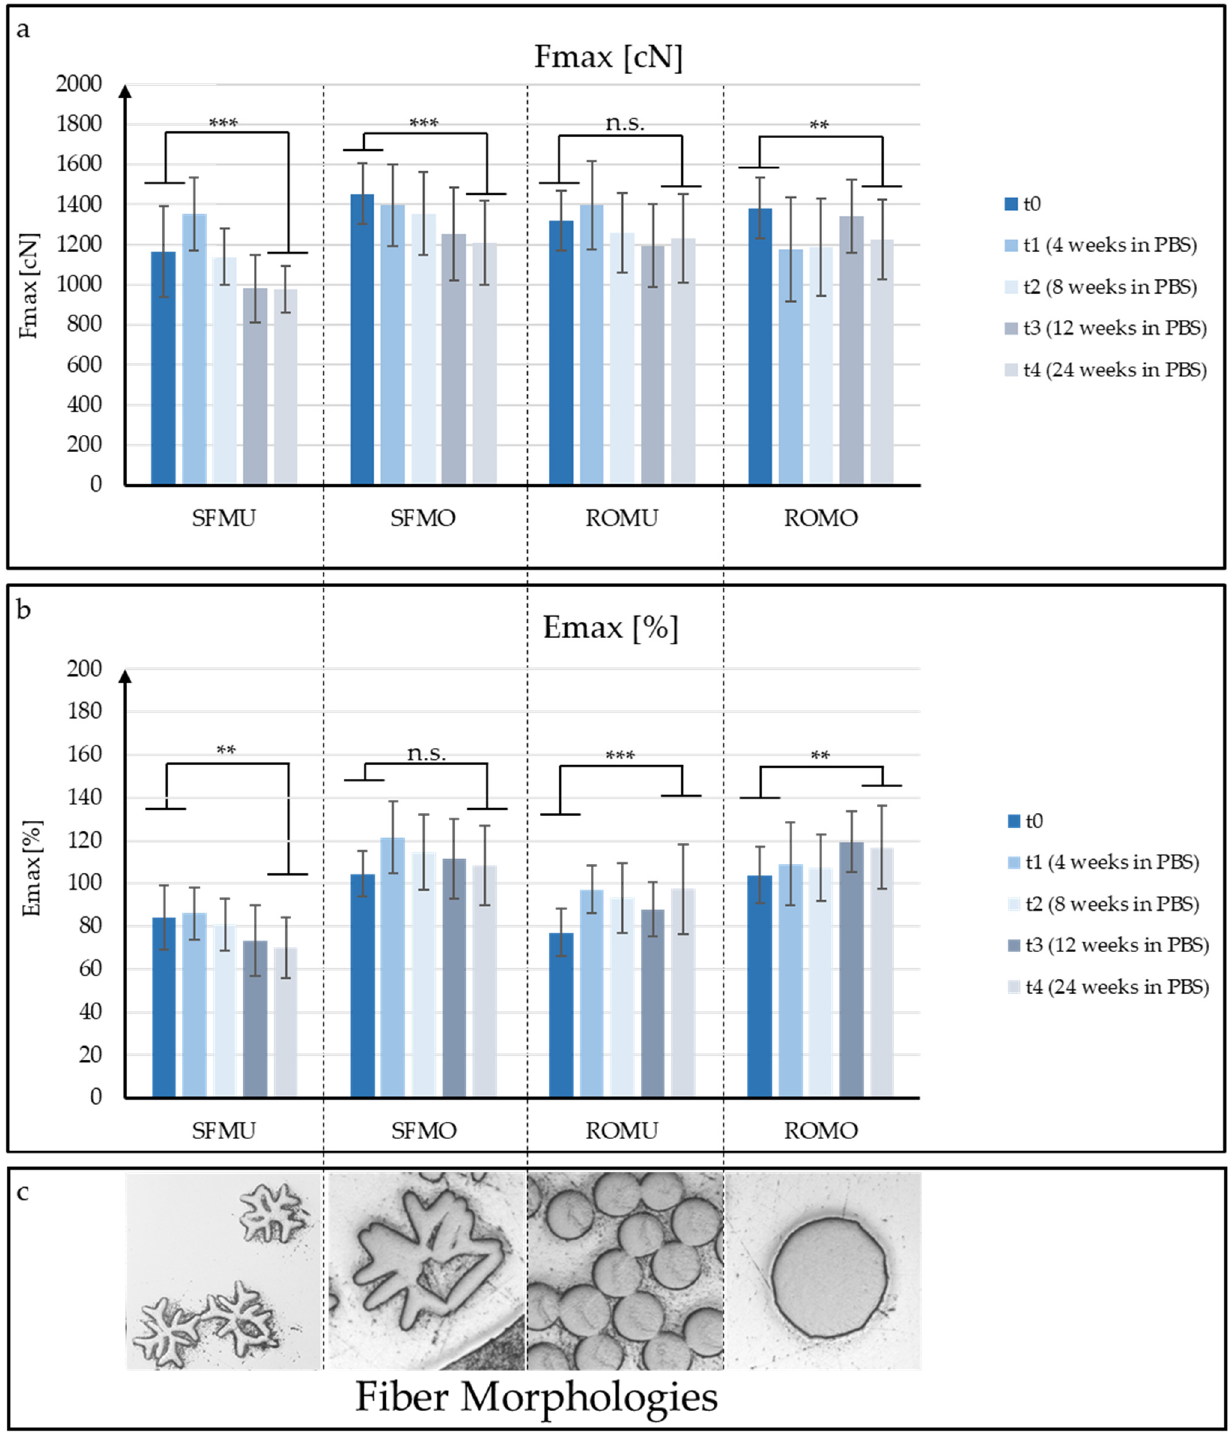
Figure 5. Mechanical fiber characterization during exposure to PBS at 37 °C for up to 24 weeks.